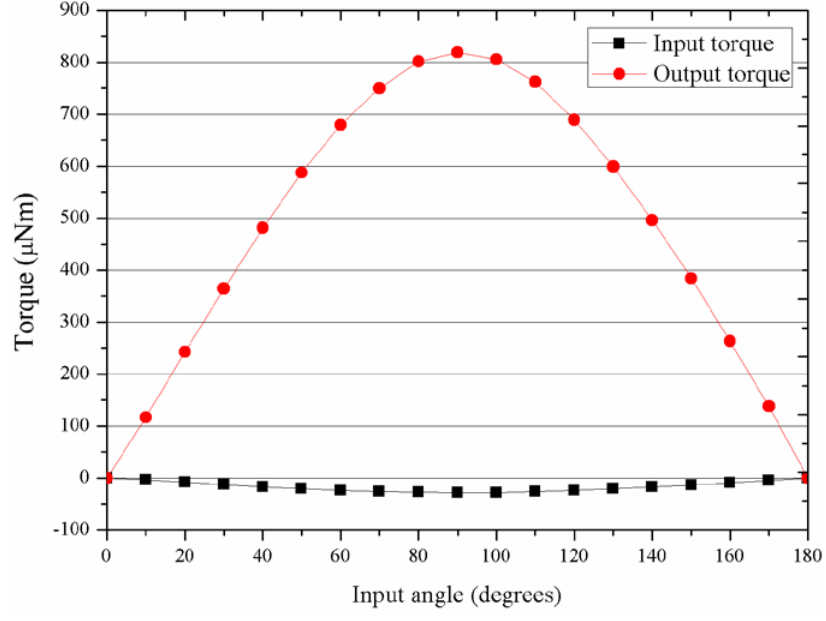
Figure 2. Input and transmitted torque simulation results for the best properties case.